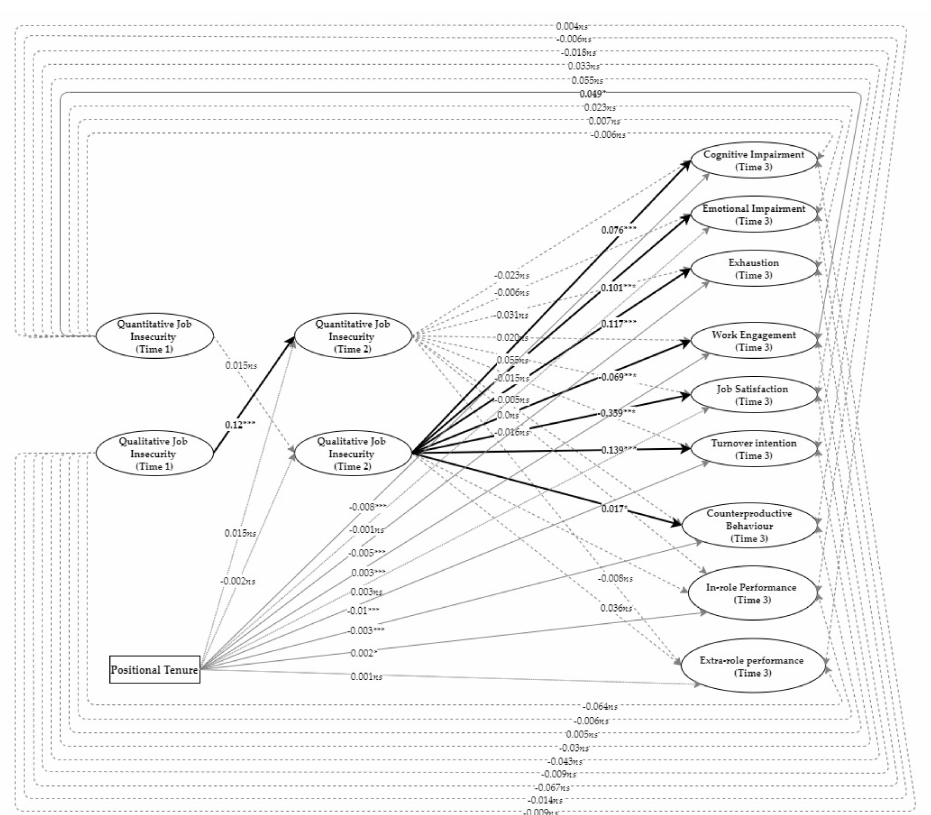
Figure A1. Final model with unstandardized path coefficients. Note: p < 0.05 *, p < 0.01 **, p < 0.001 ***. Autoregressive pathways are omitted for clarity. Dotted lines indicate non-significant re-